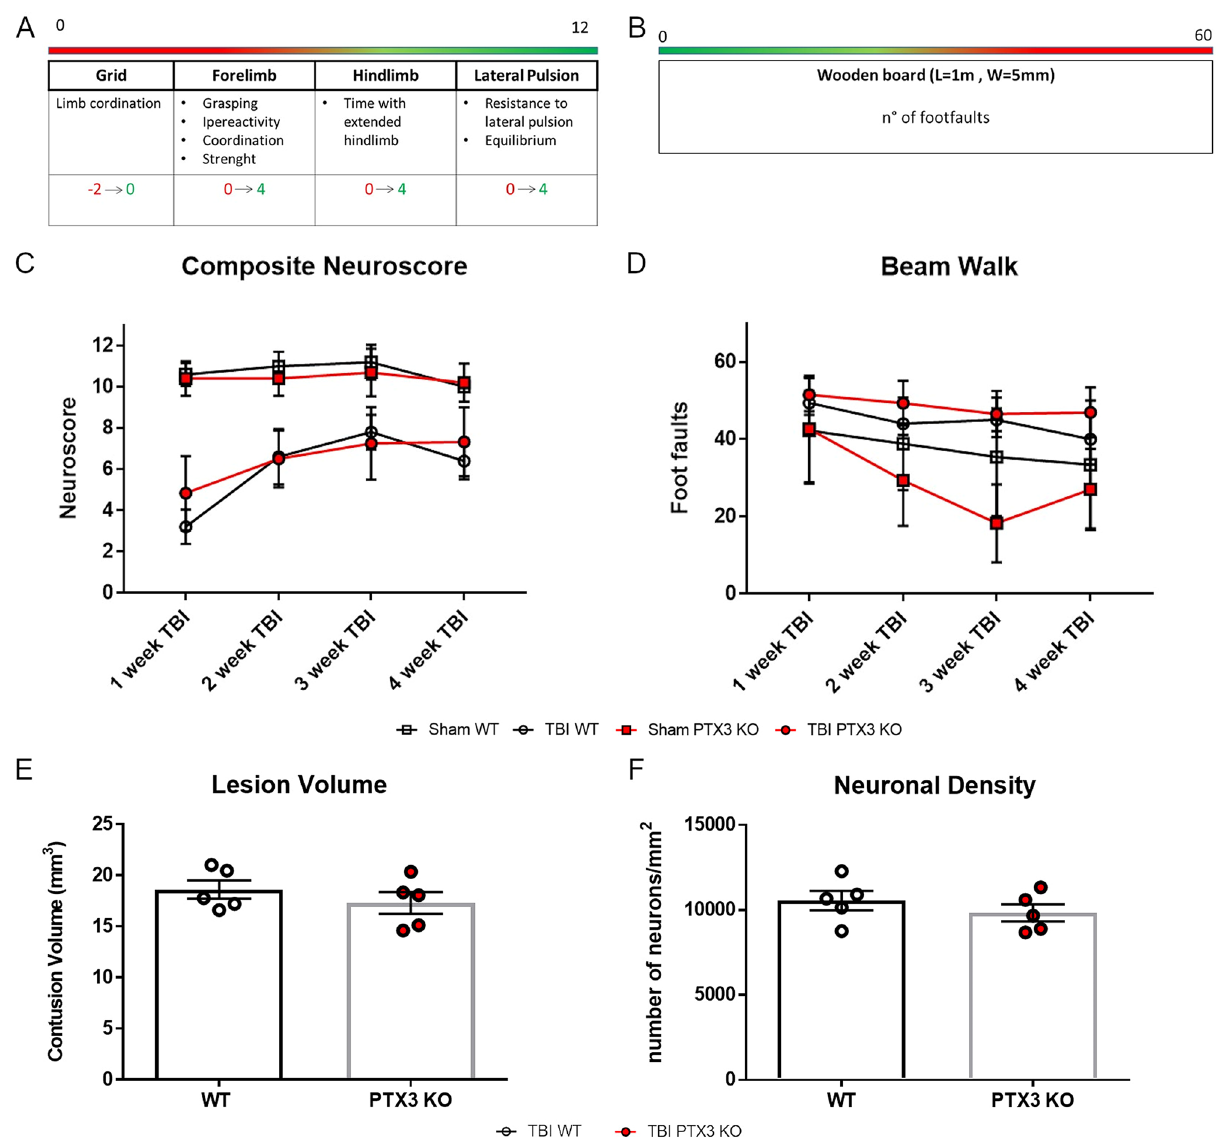
Figure 7. PTX3 depletion did not affect TBI outcome. ( A , B ) Sensorimotor function was assessed over 4 weeks after sham injury or TBI using Composite neuroscore ( A , worst score = 0) and Beam walk ( B , worst score = 60) tests in WT and PTX3 KO mice. ( C , D ) No difference was observed in post-traumatic sensorimotor deficits between the two strains. Data is presented as mean ± SEM, n = 5 (Sham/TBI WT), n = 10 (Sham PTX3 KO), n = 12 (TBI PTX3 KO). Two-way ANOVA for repeated measures followed by Bonferroni post hoc test = ns. Five weeks after TBI, neither the lesion volume ( E ) nor the neuronal density ( F , neurons per mm 2 ) in the lesioned cortex varied between WT and PTX3 KO mice. Data is presented as mean ± SEM, n = 5 (TBI WT/PTX3 KO). Unpaired t-test = ns ( E ligands in addition to microbial components 43,48 . We actually found a strong activation of PTX3 mRNA expres- sion compared to control mice in brain areas adjacent to TBI lesion core, namely cortex and striatum, occurring at early time points (24 h) and lasting up to 5w after insult. Additional brain areas next to the lesion core, such as hippocampus and thalamus, also showed PTX3 overexpression after TBI, although to a lower extent. These observations indicate that PTX3 participates in brain acute phase responses elicited by TBI in both lesion core and surrounding areas. PTX3 mRNA is still present in sub-acute and chronic responses, but exclusively in areas adjacent to the lesion core, supporting the hypothesis that, at this stage, PTX3 may have a role in the formation of the gliotic scar and/or in healing processes, as previously shown in other models or tissues 7,12 . Other members of the pentraxin family, namely the long pentraxins nPTX1 and PTX4 , but not nPTX2 (nor the short pentraxins CRP and SAP ), were also upregulated, although to a lower extent compared to PTX3 , in the cortex at the early phases after TBI, suggesting the involvement of nPTX1 and PTX4 in the acute brain responses to TBI. nPTX1 was reported to have a role in neuronal death after ischemia in vitro 49 and in vivo 50 suggesting